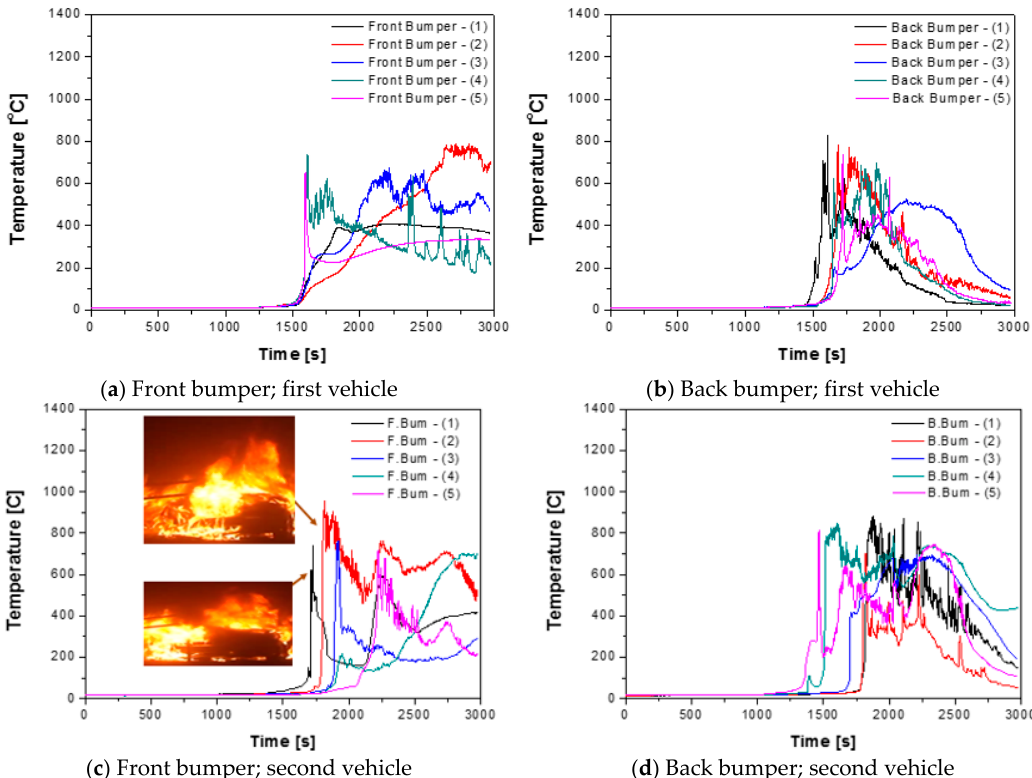
Figure 10. Temperature distribution at bumpers for one and two vehicles: ( a ) Temperature of front bumper in first vehicle, ( b ) temperature of back bumper in first vehicle, ( c ) temperature of front bumper in second vehicle, and ( d ) temperature of back bumper in second vehicle.